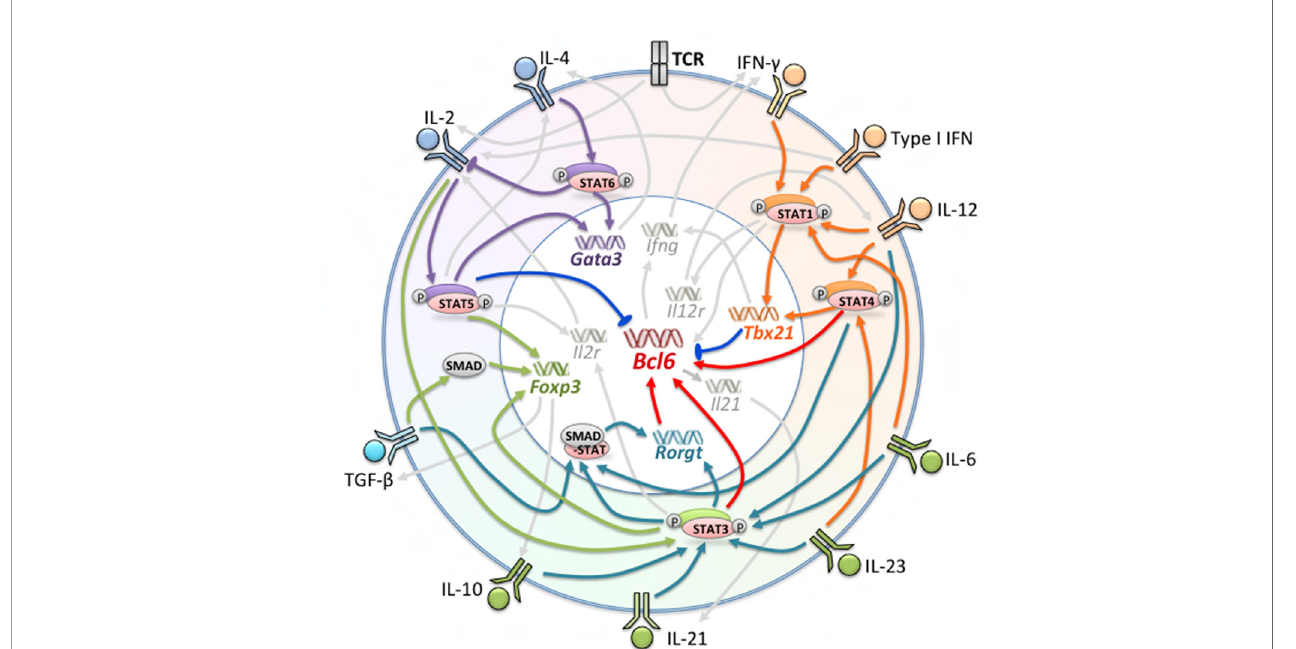
FIGURE 1 | Factors Involved in the Generation of Tfh and Tfh Subsets. Multiple cytokines, receptors, and transcription factors are involved in the differentiation of Tfh cells. The orange, green, and purple regions represent factors leading to the polarization of Tfh1, Tfh17 and Tfh2 cells, respectively. Red arrows indicate promotion of Bcl-6 expression; blue arrows indicate suppression of Bcl-6 expression; orange, dark green, purple, and light green arrows indicate major regulated factors of Tfh1, Tfh17, Tfh2, and Tfr,